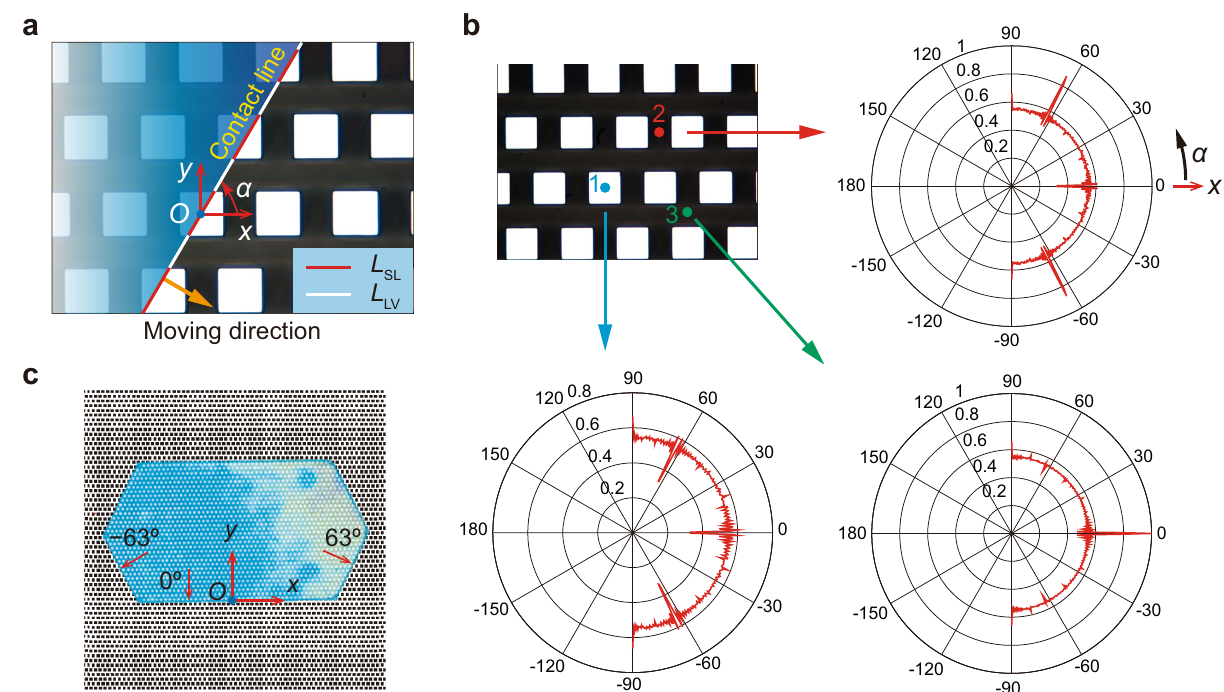
Fig. 2 Moving direction of the solid-liquid-vapour three-phase contact line. a Schematic representation of the pillars (white color) and contact line from a top view. The dot marked with “ O ” represents the reference point. The moving direction of the three-phase contact line is marked using an orange arrow. The red and white lines represent the solid-liquid contact line L SL and liquid-vapour part L LV , respectively. α is de fi ned as the angle (having a positive value in anticlockwise direction) between the contact line and the x -axis. b Diagram illustrating the liquid-vapour line fraction ε ( α ) = L LV / L as the function of α in the polar coordinate system for different reference points. c Final con fi guration of the droplet (Supplementary Movie 9). The block directions (red arrows) α ≈ 63°, 0°, and – 63° are obtained from ( b ). Source data are provided as a Source Data fi